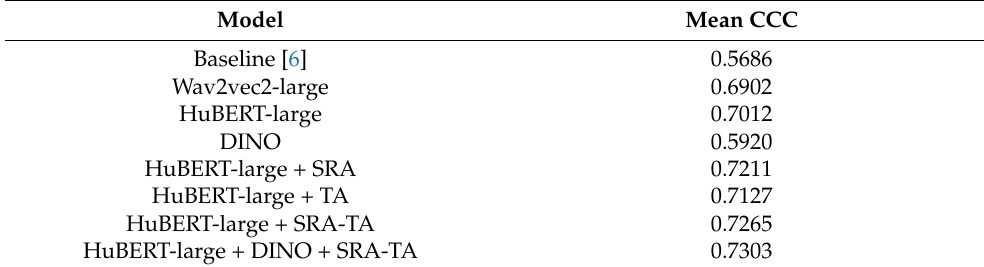
Table 1. The mean CCC on validation dataset from different